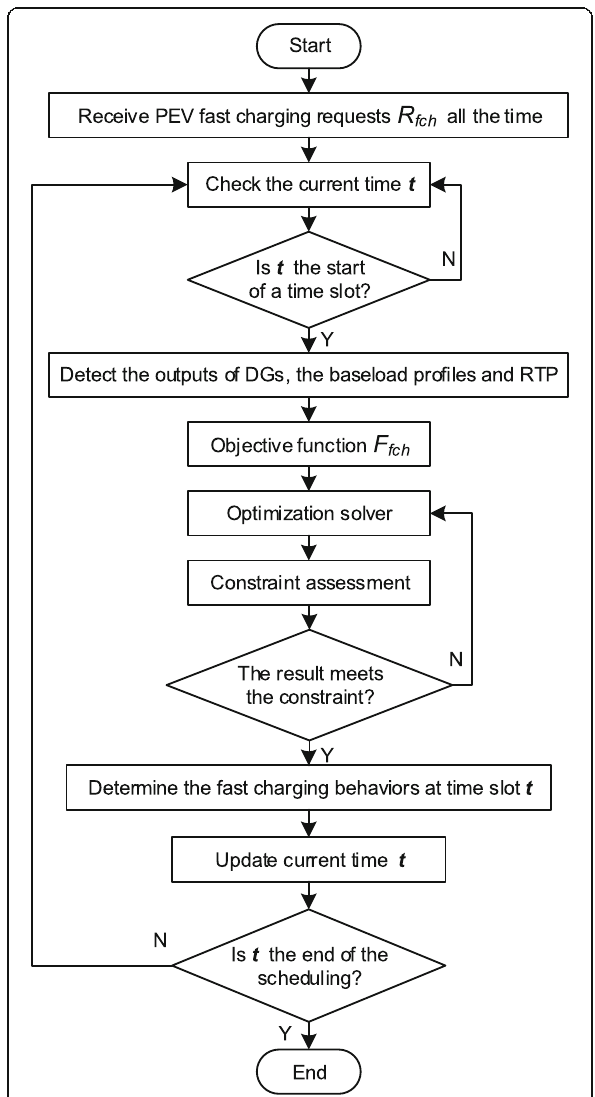
Fig. 2 The flowchart of spatial scheduling strategy of fast